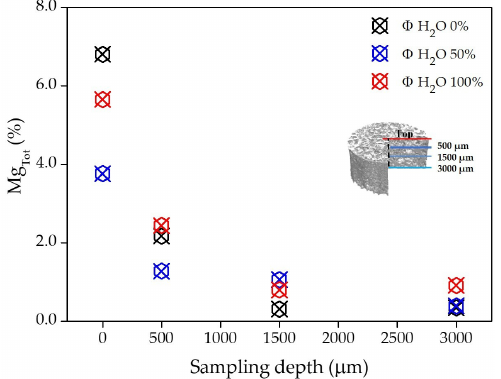
Figure 4. XPS surface magnesium percentage (Mg Tot %) in the core of PCL scaffolds as a function of the sampling depth from the top.